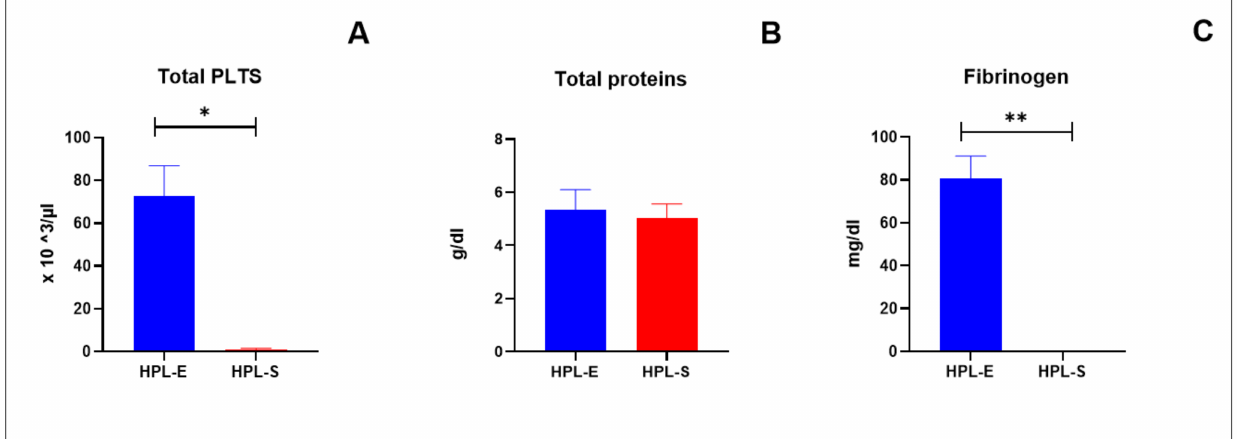
Figure 2. Chemical analyses performed in HPL-E (blue column) and in HPL-S (red column). Each column represents the mean with SEM of 4 batches of each HPL. No significant differences were observed between HPL-E and HPL-S in total proteins ( B ), but the absence of fibrinogen ( C ) and total PLTs ( A ) were significant in HPL-S in comparison with HPL-E. * and ** indicate, respectively, a significant ( p < 0.05) and a highly significant ( p < 0.01)